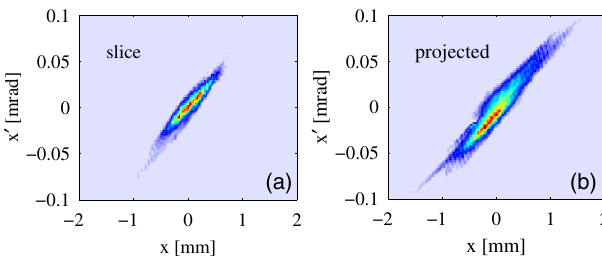
phase space distribution of (a) a single slice at (cid:2) ¼ 0 and (b) an entire uncompressed